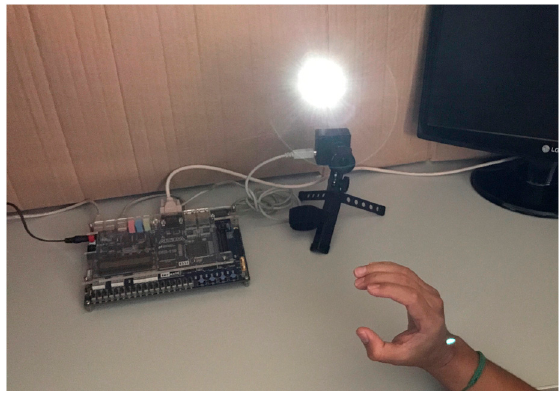
Figure 1. Experimental setup.